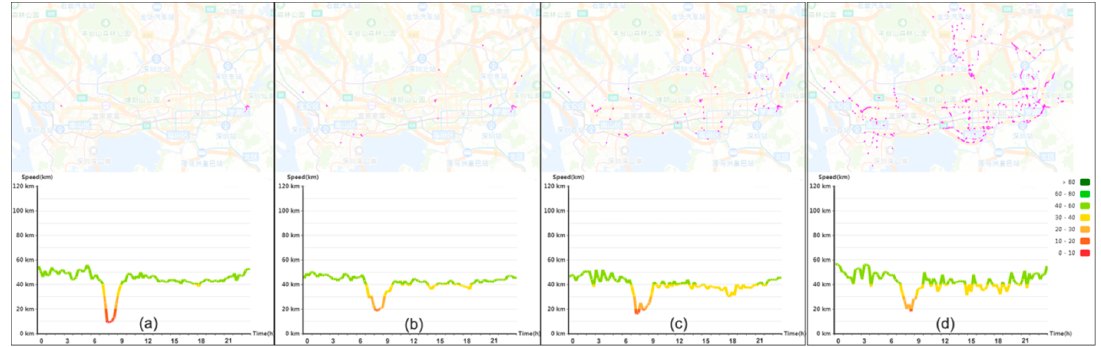
Figure 7. Results of road links with a specified pattern for different TV distance values. The similarity indicator is ( a ) 0.88; ( b ) 0.86; ( c ) 0.84; and ( d ) 0.82.